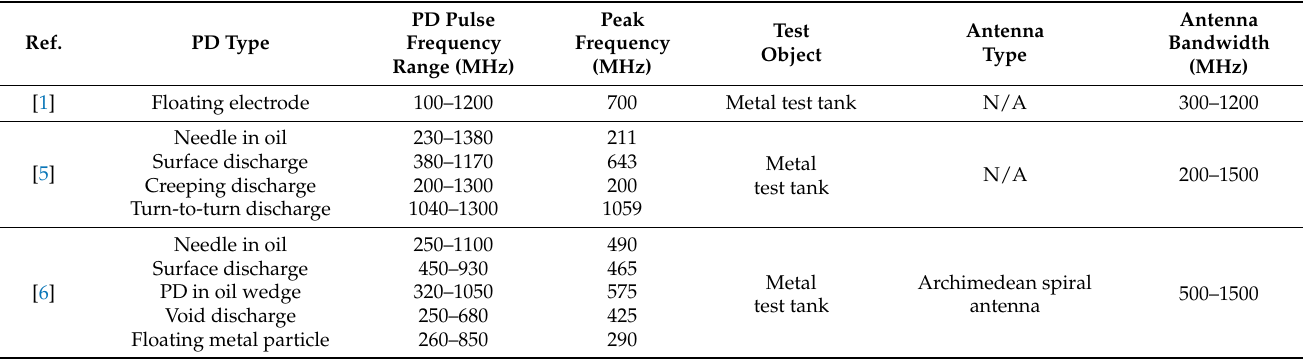
Table 1. Influence of the type of antenna and test object on the frequency parameters of PDs.